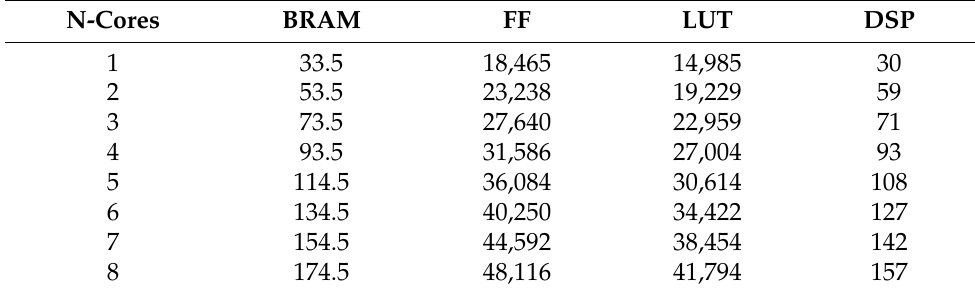
Figure 9. The graph shows the percentage of resources consumed when increasing the number of cores on the Ultra96 board. Table 2. Hardware resource consumption using a different number of cores on Ultra96